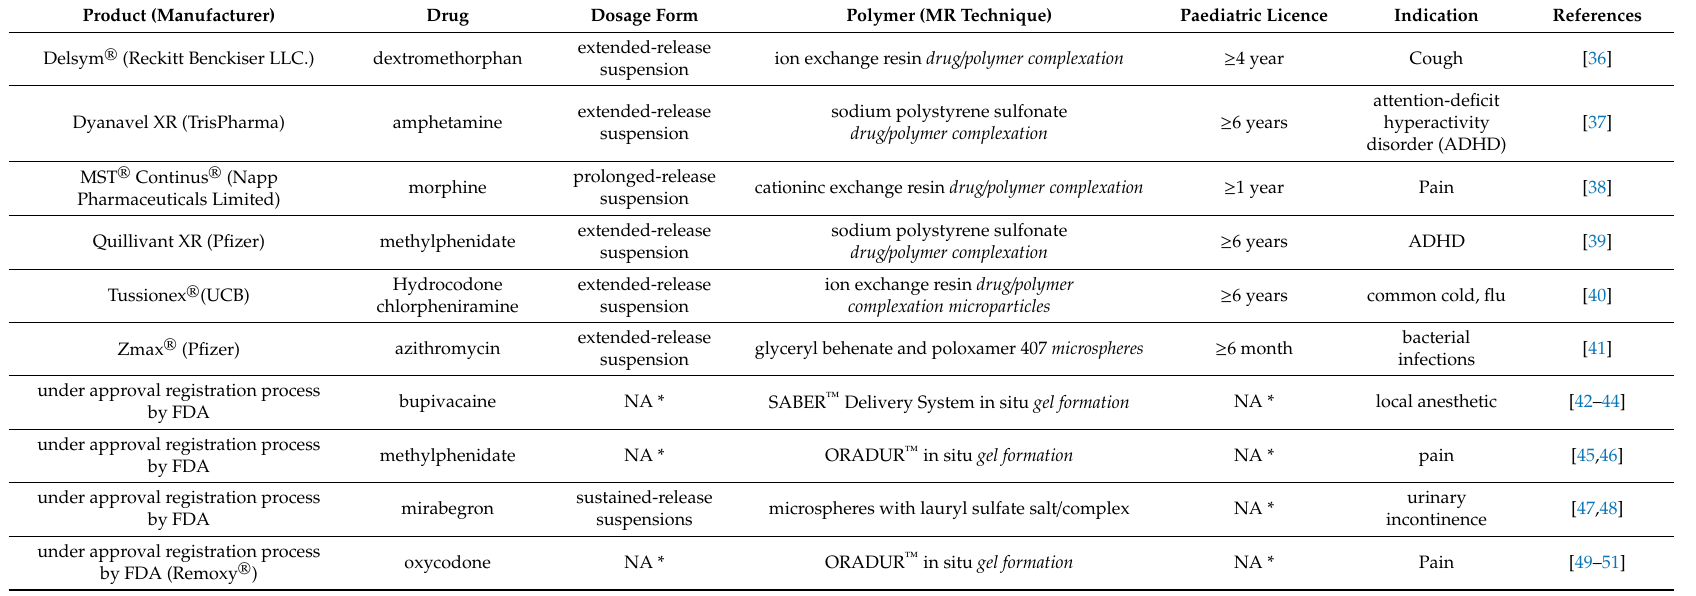
Table 1. Modified release oral liquid dosage forms—an overview of available formulations with paediatric license and drugs with finished clinical trials being under approval registration process by the Food and Drug Administration